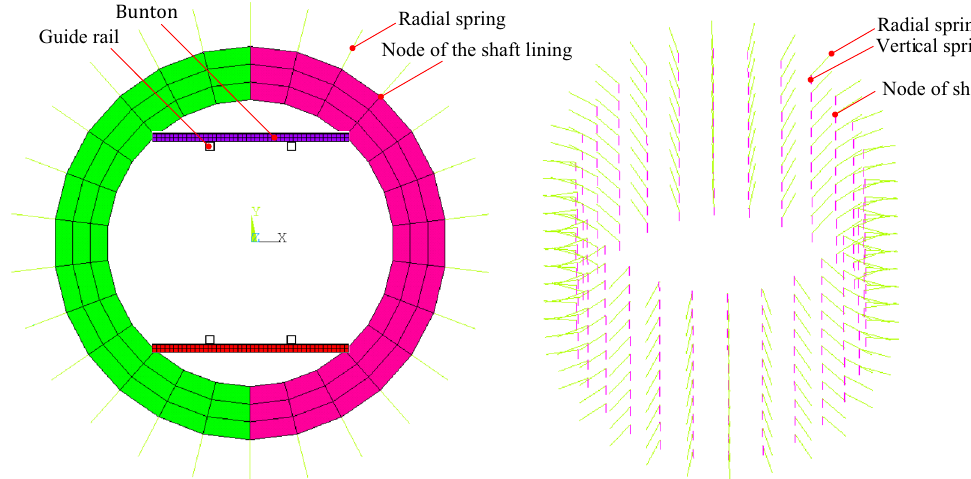
(b) Spring layout in shaft lining node(a) Planform of meshing result